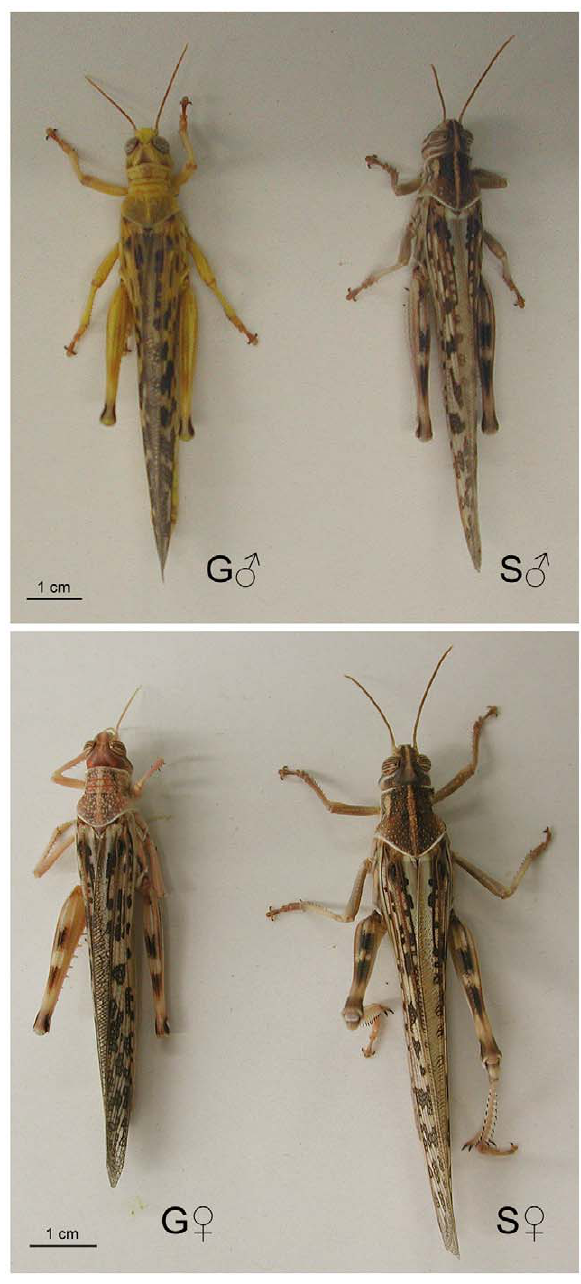
Figure 1. Adult gregarious and solitarious desert locusts. The upper and lower panels show males ( = ) and females ( R ) of the gregarious (G) or solitarious (S) phases.